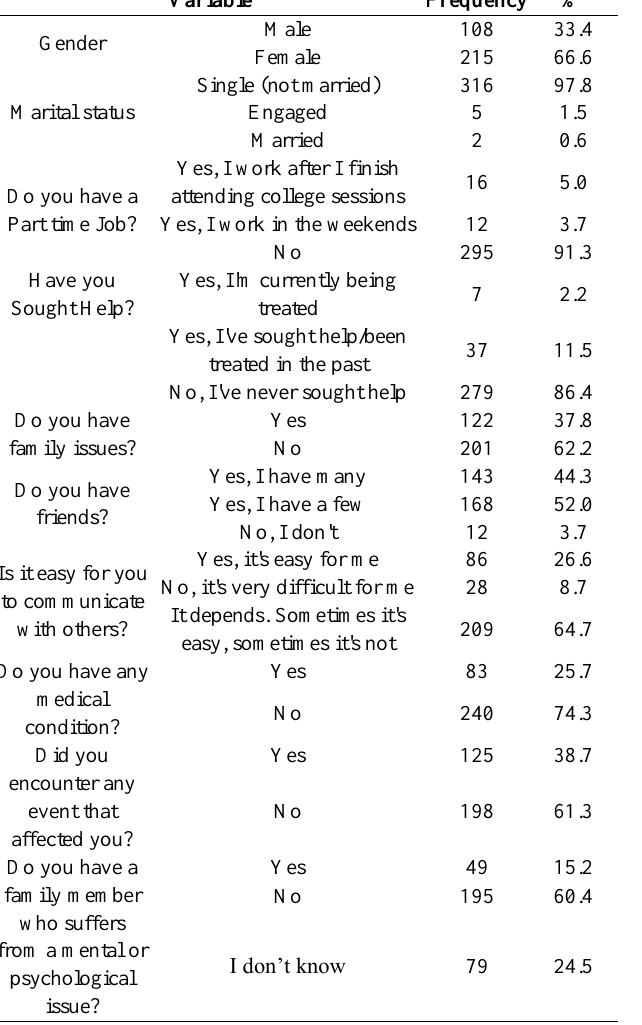
Table 1: Distribution of participants according to their demographic data